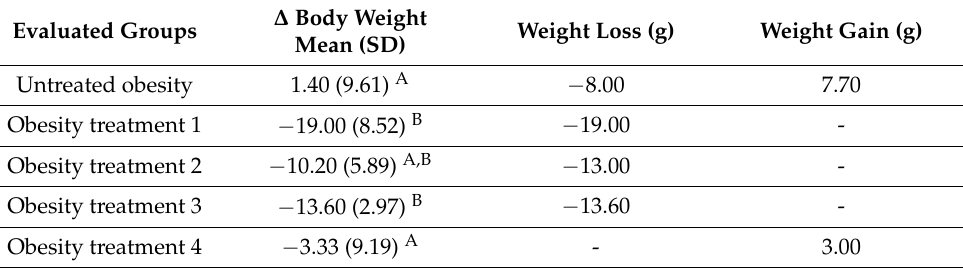
Table 3. Body weight variation in Wistar rats with obesity induced by HGLI diet submitted for ten days to different types of